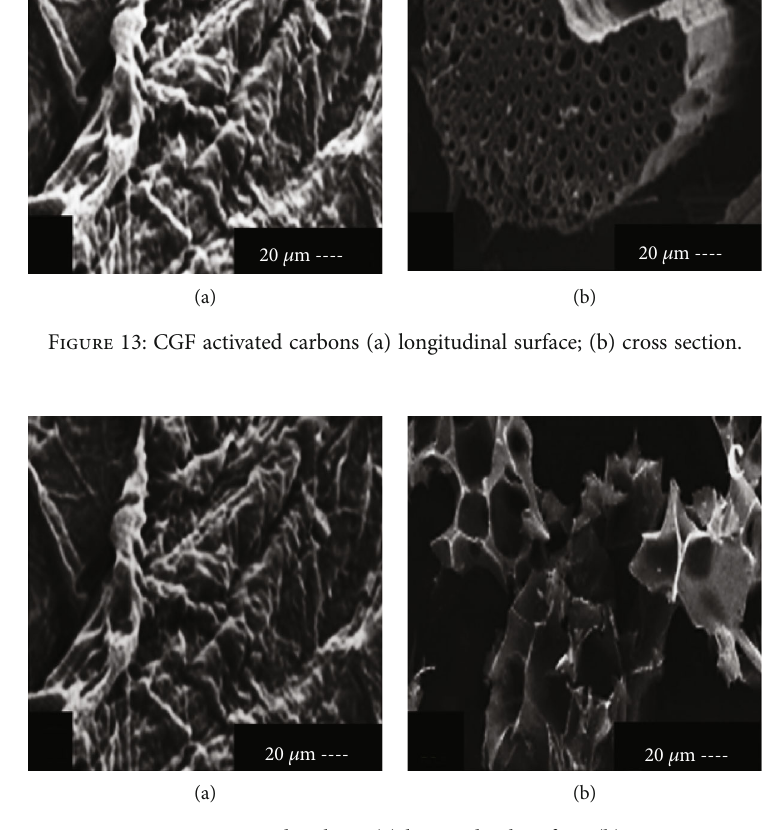
Figure 14: Hemp activated carbons (a) longitudinal surface; (b) cross